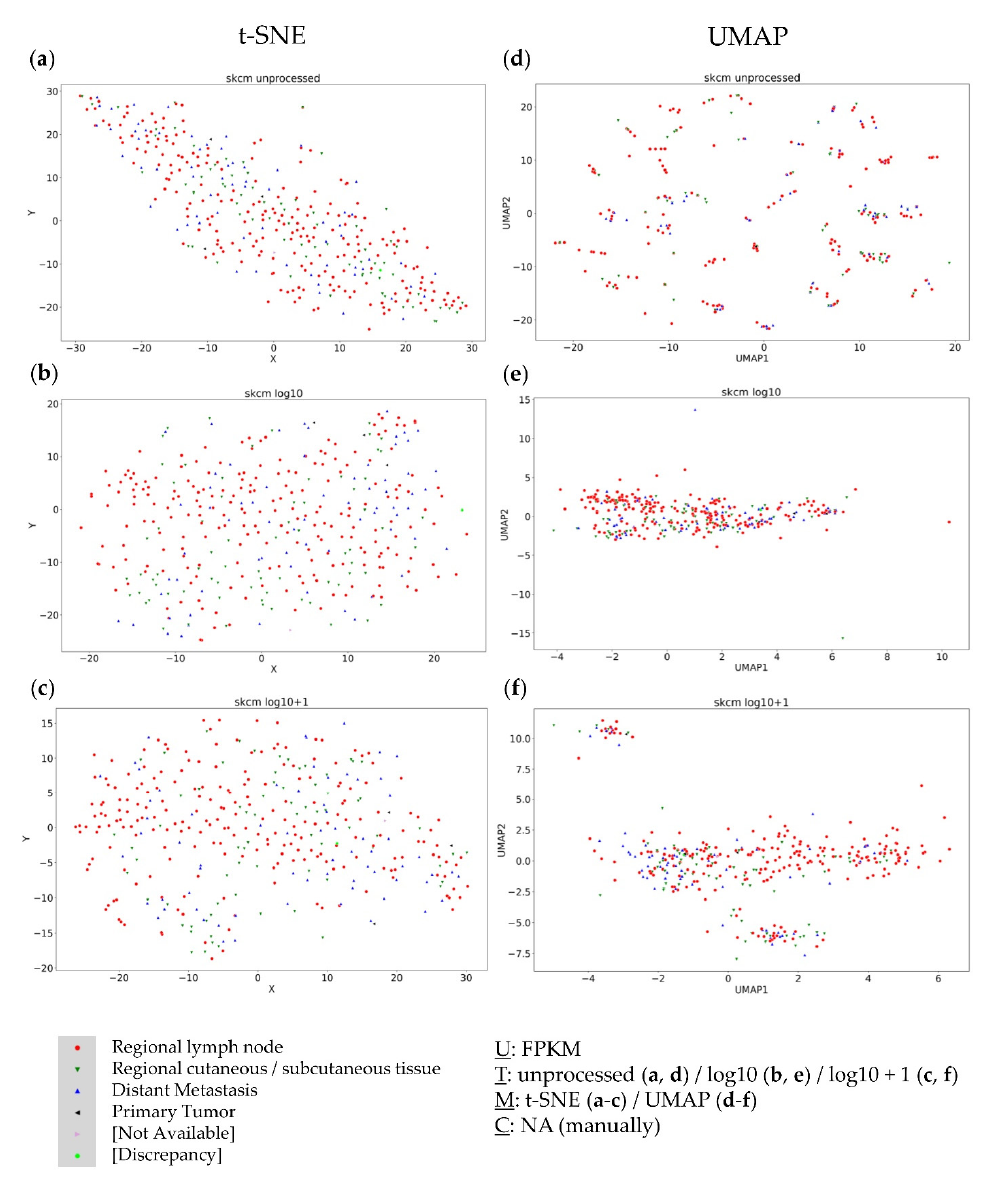
Figure 3. Visual clustering of the metastatic TCGA-SKCM dataset consisting of melanoma metastases (with respective resection sites) by applying different data dimension reduction methods. t-SNE plot approach for ( a ) unprocessed, ( b ) log10 transformed, and ( c ) log10 + 1 transformed FPKM values and UMAP approach using ( d ) unprocessed, ( e ) log10 transformed, and ( f ) log10 + 1 transformed FPKM values. FPKM: Fragments Per Kilobase Million; U: unit, T: transformation, M: data dimension reduction method, C: clustering method, NA: not